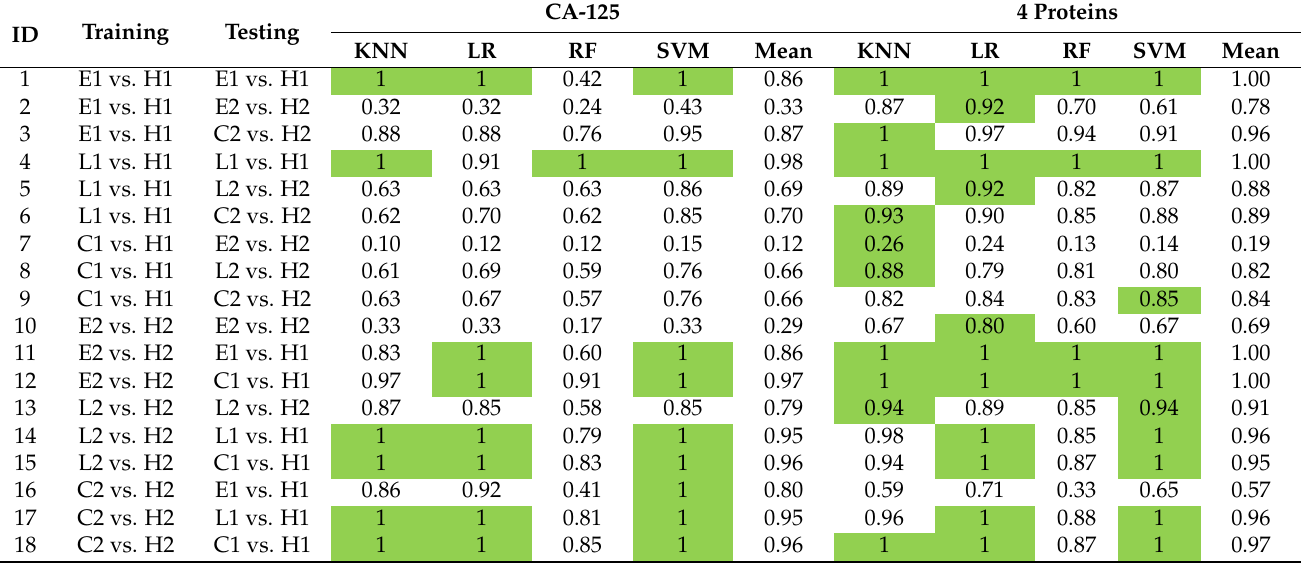
Table 5. The comparison of positive predicted value (PPV) between CA-125 alone and all four proteins (CA-125, MIF, OPN, and PROL) when using the four classification techniques, namely K-Nearest Neighbor (KNN), Logistic Regression (LR), Random Forest (RF), and Support Vector Machine (SVM). The PPV measures the liability of a positive test result and is defined as the ratio of the number of condition samples correctly identified to the total number of positive test results. We highlighted the cell(s) with best PPV in each experiment. In general, using logistic regression and all four proteins yield the best results on most